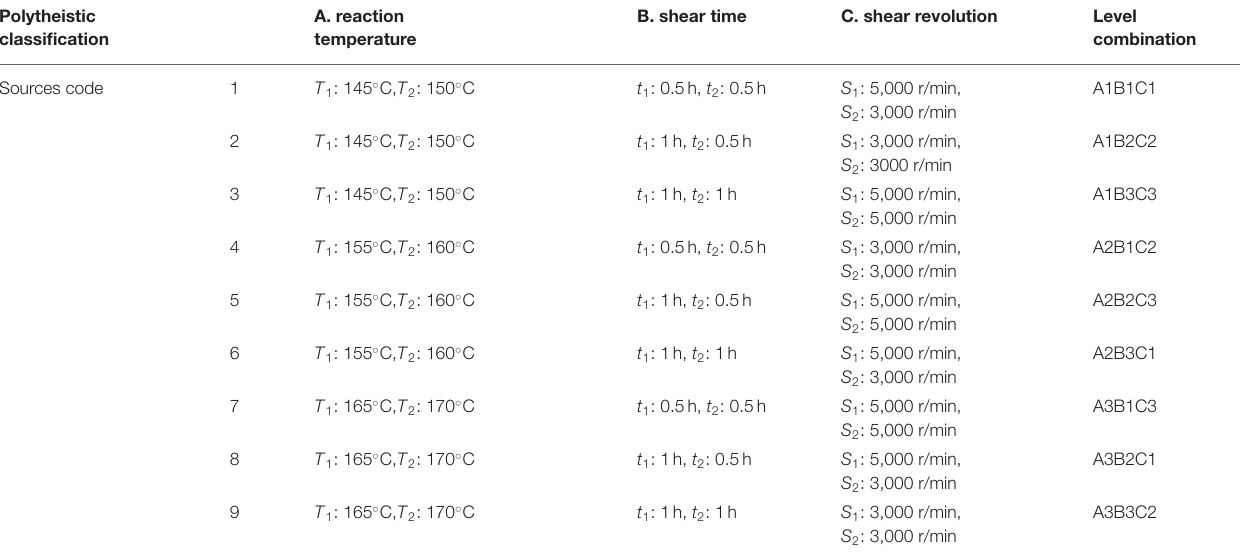
TABLE 2 | Three factors and three levels about orthogonal experimental